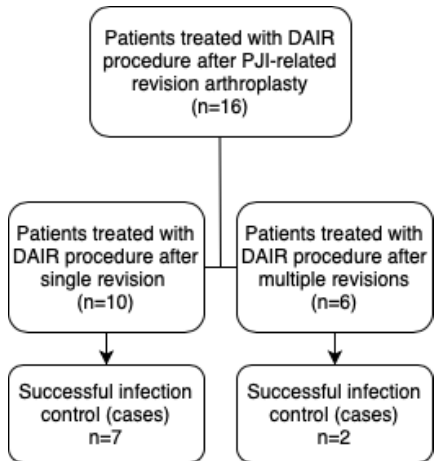
Figure 2. Flow diagram showing the numbers of patients with suc- cessfully controlled infections according to the frequency of previ- ous PJI-related revision